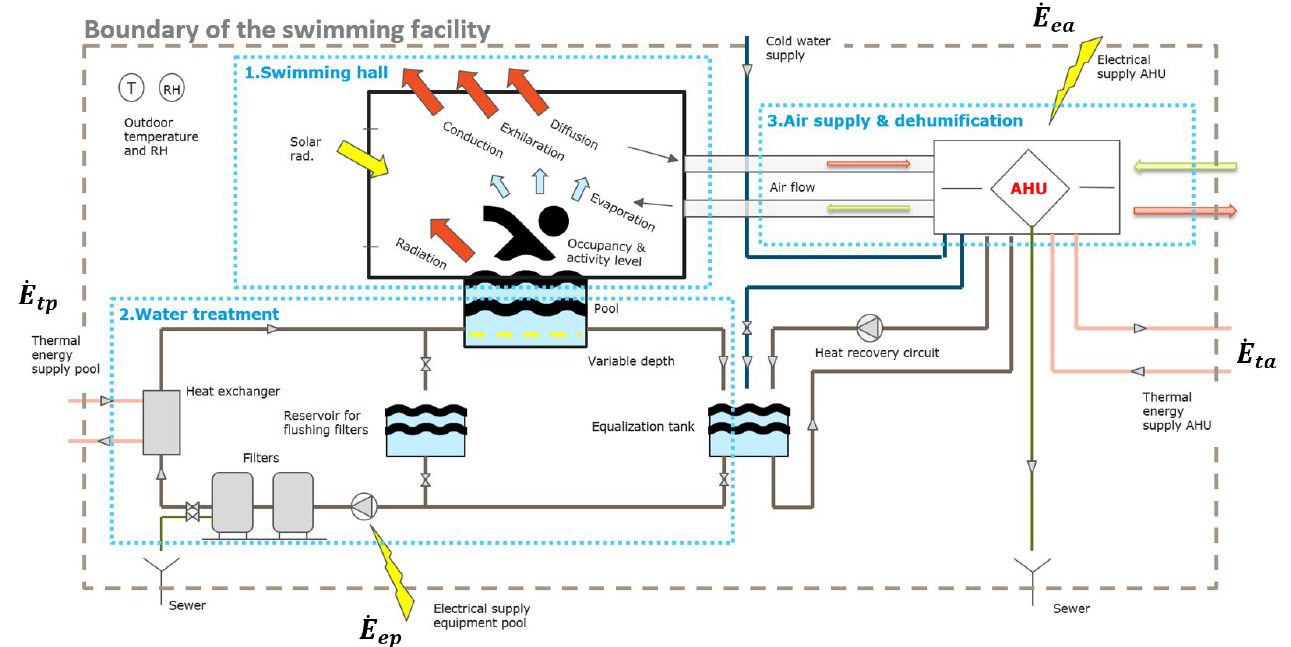
Figure 1. An overview of the extent of the technical systems in a typical swimming pool